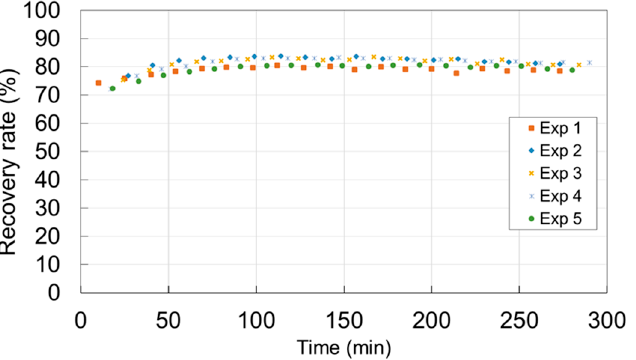
Figure 10. Comparison of toluene recovery ratio vs. time for different experiment cycles—catalyst m 2— 𝜓 (cid:3404) 0.98/2 .